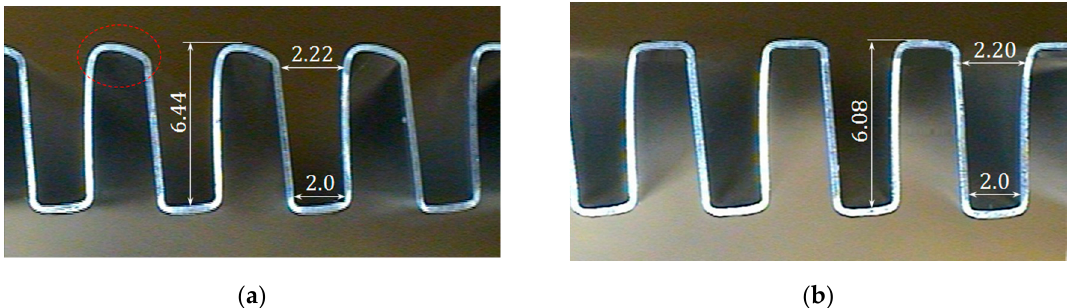
Figure 12. Cross-sectional shape of the formed fin by a digital microscope (unit: mm): ( a ) punch and die in Figure 2 and ( b ) punch and die in Figure 10a.